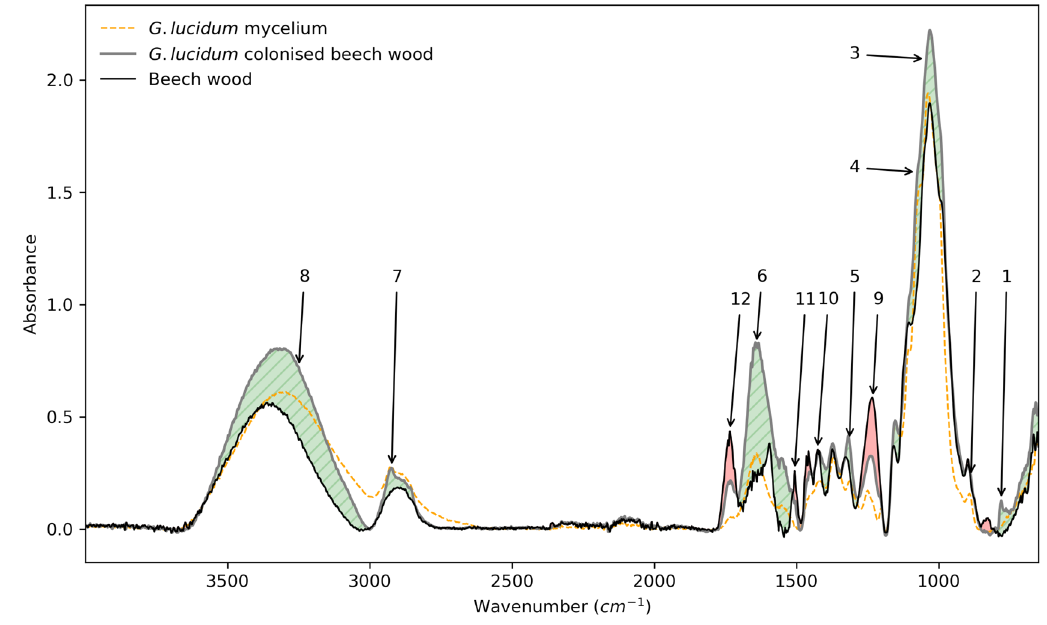
Figure 2. FTIR spectra of G. lucidum colonised beech wood, G. lucidum mycelium, and beech wood. Green areas represent increased values in mycelium-colonised specimens (peaks 1 to 8), red areas are decreased values in mycelium-colonised specimens (peaks 9 to